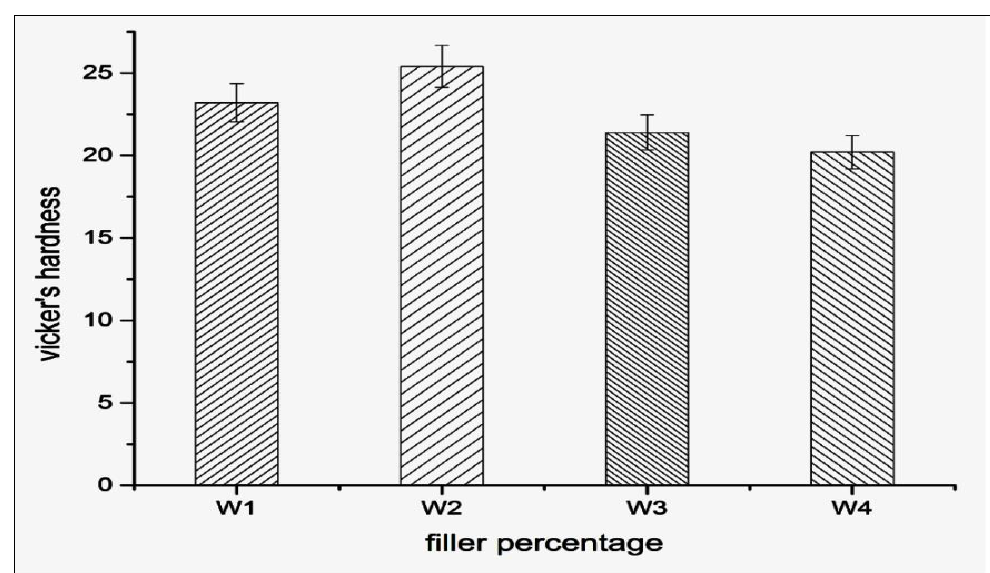
Figure 3. Hardness of Epoxy nanocomposites with addition of different wt% of WC